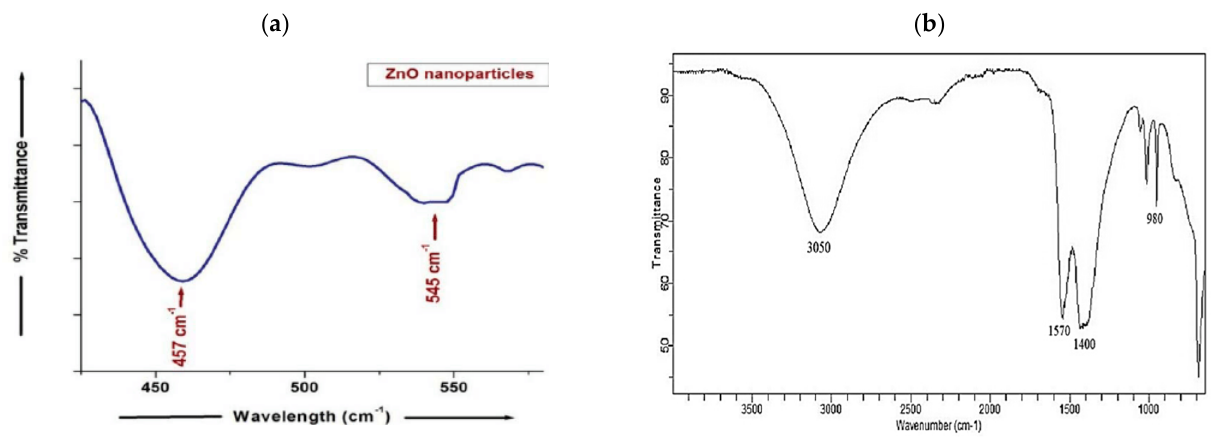
Figure 10. FTIR spectra of the ( a ) optimum sample and ( b ) guava leave extract. Table 4. Zone of inhibition of control and optimum cotton samples against gram-positive and gram-negative bacteria. Zone of Inhabitation against Gram-Positive Bacteria Zone of Inhabitation against Gram-Negative